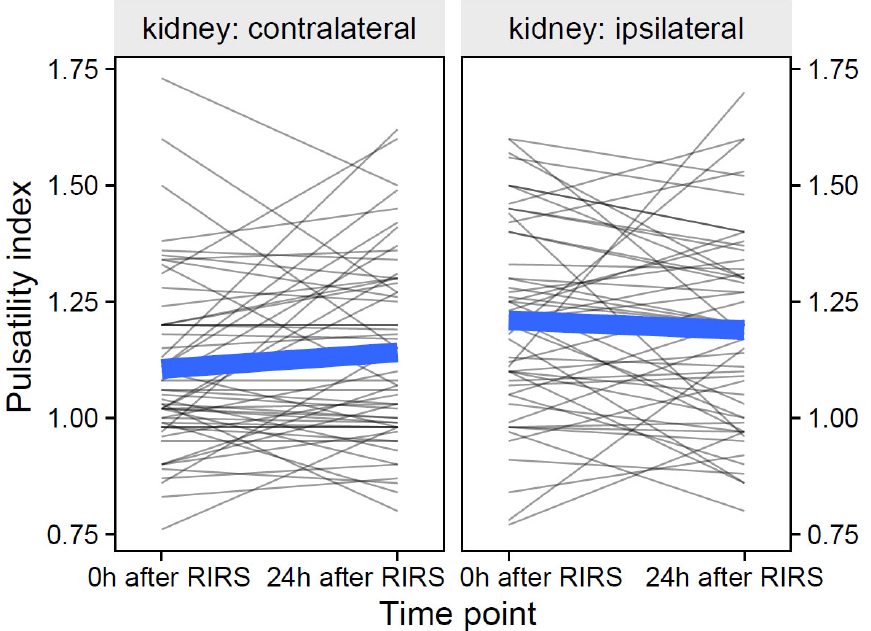
Figure 11. The effect of kidney side on the pulsatility index over time (the thin, semitransparent black lines in the background are the individual-level data. The bold blue lines in the foreground are the group averages). The figure shows that the effects of the kidney side on the focal variable of the pulsatility index were obviously different over time. The inclusion of the effects of mean stone volume, energy used, pre-stenting, and kidney side at separate time points is presented in Sections